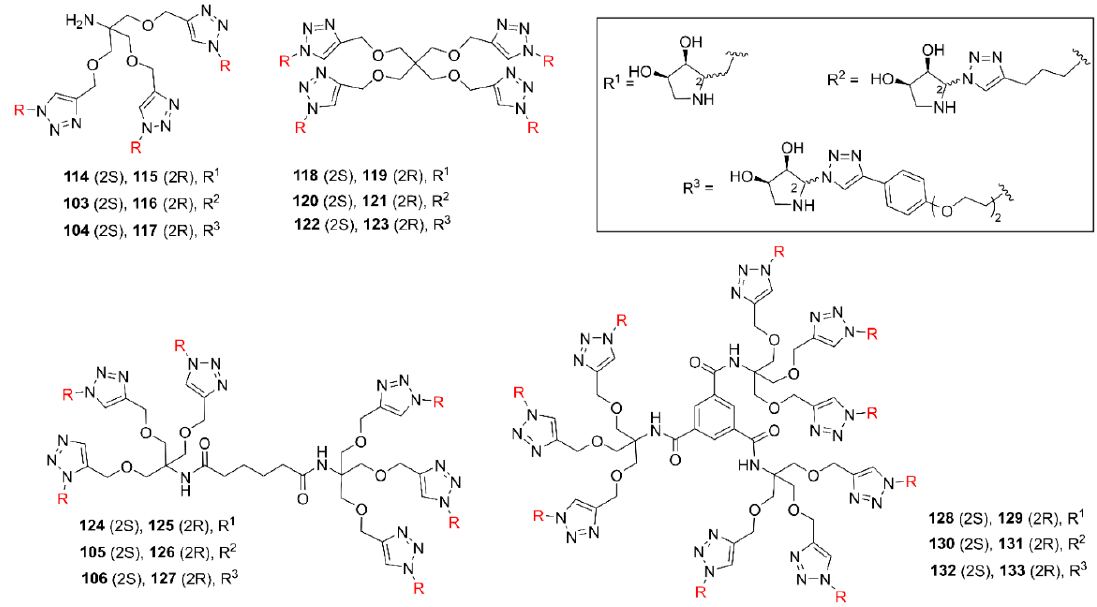
Figure 9 . Tri-, tetra-, hexa- and nonavalent iminosugars 114 – 133 .